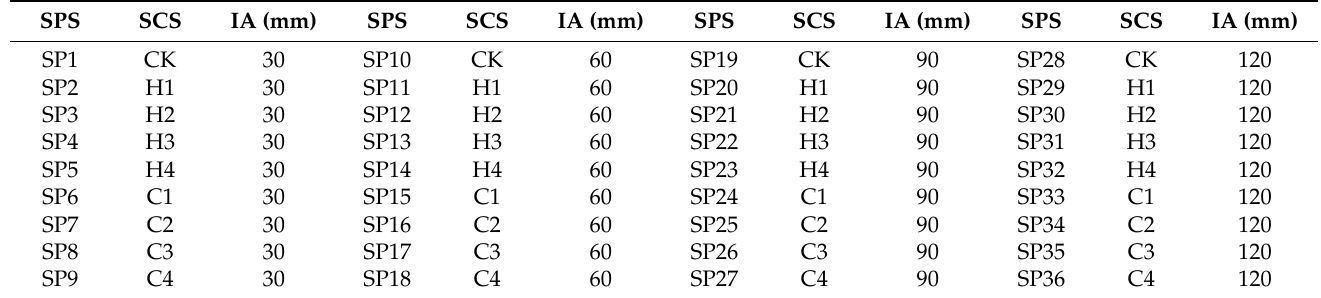
Table 4. Simulation programs of AquaCrop.